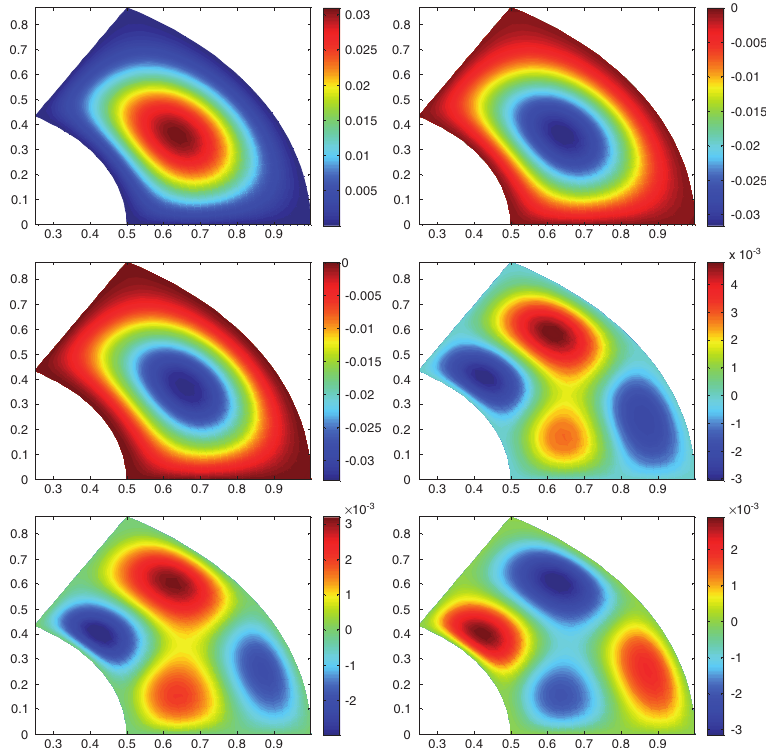
Figure 16 The first mode shapes of a fully clamped orthotropic FGM annular sector plate for different Winkler parameters: (A) 5e9, (B) 10e9, (C) 50e9, (D) 100e9, (E) 500e9 and (F) 1000e9 ( θ = 60 ° and n = 0.1).